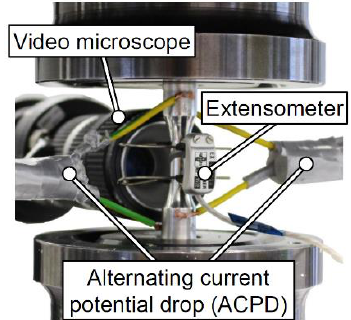
Figure 4. Experimental setup of resonant fatigue testing system equipped with extensometer, ACPD, and video microscope (cf. [38]).